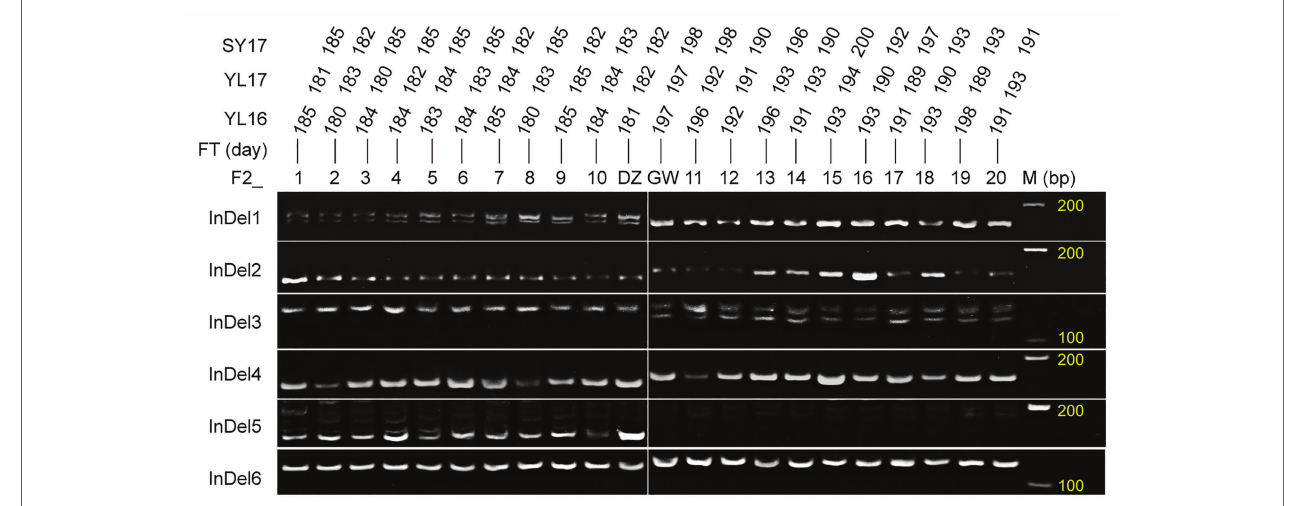
FIGURE 6 | Validation of the developed InDel markers using the parents (female GW and male DZ) and extreme plants. F2_1–10 and 11–20 represent the early and late flowering plants that were screened out according to the flowering time of Yangling in 2016 (YL16), Yangling in 2017 (YL17), and Sanyuan in 2017 (SY17) among the F 2a